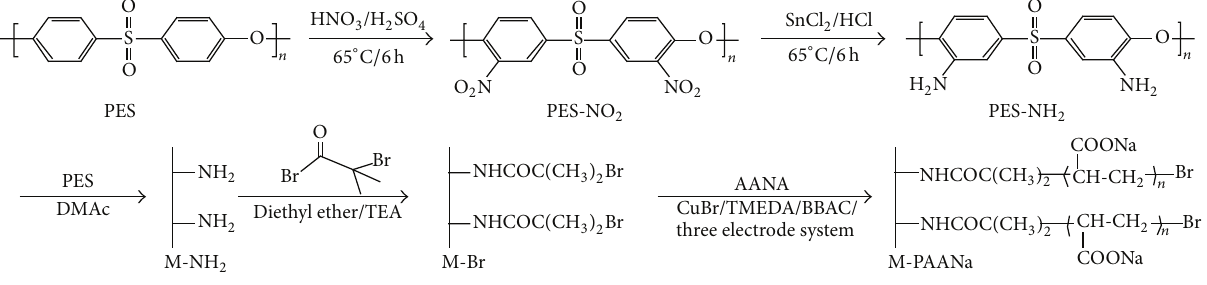
Scheme 1: Schematic diagram for preparation process of the M-PAANa.